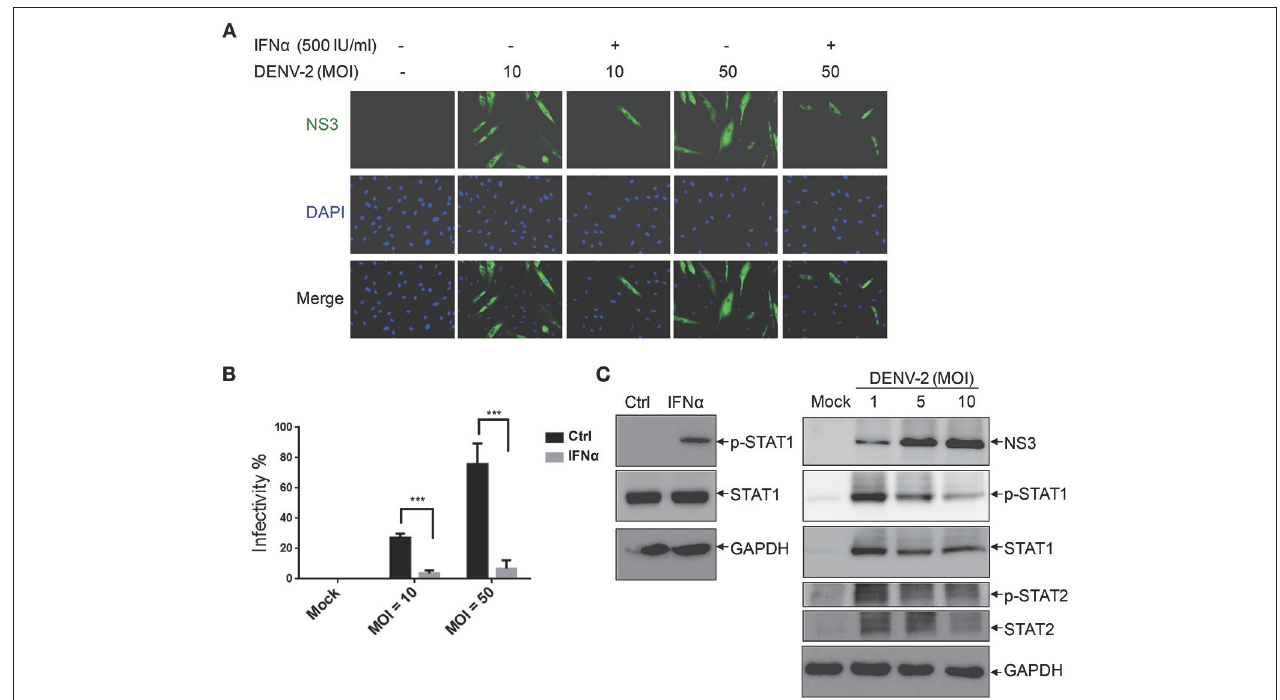
FIGURE 2 | Interferon α (IFN α ) inhibits DENV-2 in HFDPCs. (A) HFDPCs (4 × 10 4 cells/well) were pretreated with IFN α (500 U/ml) before DENV-2 infection at MOI 10 and 50 for 4 days. Immunofluorescence assay of DENV-infected cells (green fluorescence) with anti-NS3 antibody. Cell nuclei are stained with DAPI (blue fluorescence). Merged images are also presented. (B) Quantification of DENV-2-infected cells. Data are mean ± SD of three observation fields. *** P < 0.005 vs. untreated control. (C) Left panels, HFDPCs (1 × 10 5 ) were treated with IFN α -2a (1,000 U/ml) for 6h, the untreated cells are indicated as ctrl. Right panels, HFDPCs infected with untreated control or DENV2 at MOI = 1, 5, and 10 for 4 days. Immunoblotting of levels of phospho-STAT1/STAT2 and total STAT1/STAT2 in whole cell extracts. DENV-2 NS3 indicates viral infection and GAPDH is the loading control. The represented data are from the consistent results of two or three independent